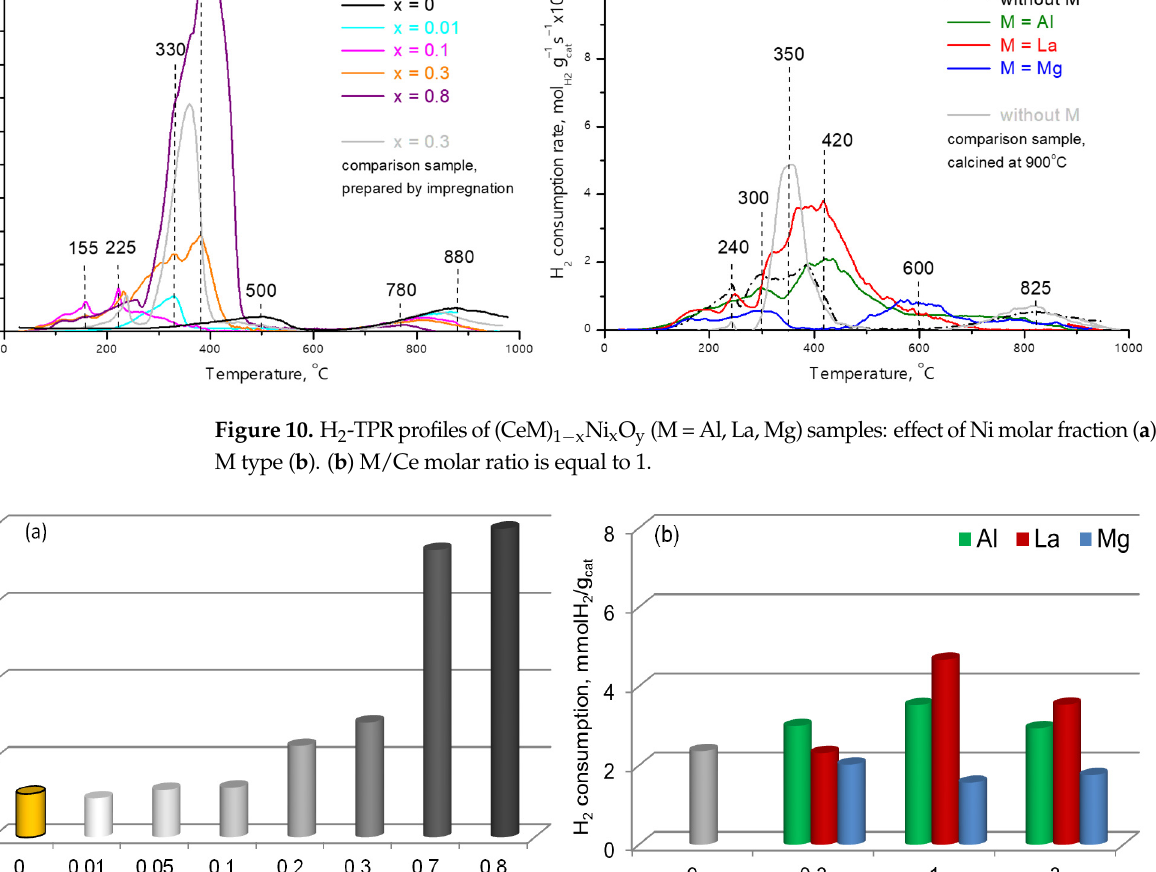
Figure 12. In situ XRD patterns for (CeM) 1 − x Ni x O y samples under reduction in a 30%H 2 /70%He mix- ture as a function of temperature: ( a ) Ce 0.8 Ni 0.2 O 1.8 , ( b ) Ce 0.4 M 0.4 Ni 0.2 O y . Arrows indicate the shift in the reflection (220) of the CeO 2 phase due to doping with lanthanum cations. The evolution of the unit cell volume of a CeO 2 -based solid solution during reduction exhibits a complex pattern (Figure 13). With thermal treatment, thermal expansion of the lattice is expected, while a sudden change in the slope may be associated with a chemical process [36,70,81,105]. Indeed, for the (CeM) 1 − x Ni x O y samples, there is a region where the expected growth of the unit cell volume due to thermal expansion does not occur. Note that this behavior is typical only for Ni-containing samples. For nickel-free oxides (dot